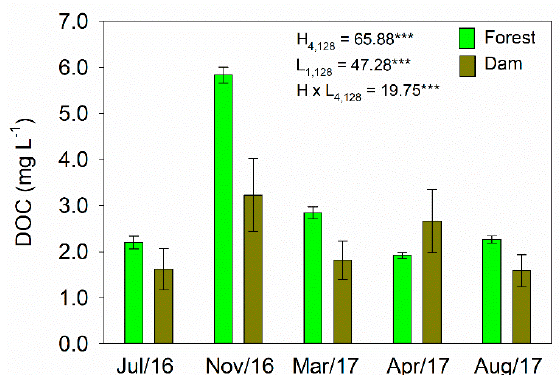
Figure 3. Mean dissolved organic carbon (DOC) (±95% CI, n = 11 Dam; n = 15 Forest) at the research site, grouped by Dam and Forest catchments and hydrologic month. The statistical results are expressed using the Tamhane test of non-presumed equal variances and the probability of type I error (P) to test with land cover (L) and hydrological month (H) as fixed effects. *** p < 0.001. Fluorescence index (FI) values varied between 1.29 and 1.41 during all months and for both catchments, indicating that DOC was predominantly derived from terrestrial sources in both areas (FI < 1.5) (Figure 4a, Table S1). The mean values of the FI showed significant differences between the catchments, with greater values in the Dam catchment in relation to the Forest catchment during all months (Figure 4a, Table S1). The values for spectral slope (SR) were significantly different between catchments and months for the complete set of data (Figure 4b). SR ranged from 0.74 to 1.25 and the highest SR values were found in the Dam catchment in all months compared to the Forest catchment (Figure 4b, Table S1). Higher variability among SR values for different sampling dates was found in the Dam catchment, mainly in months of July 2016, November 2016 and March 2017, which presented values suggesting DOM predominantly comprised of compounds with higher molecular weight (Figure 4b, Table S1).